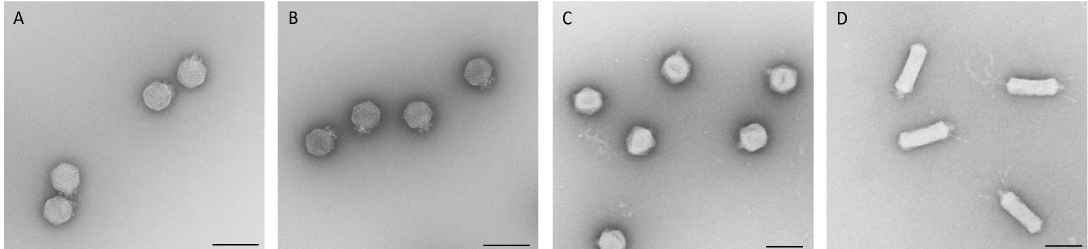
Figure 2. Electron micrographs of isolated phages HASG4 ( A ), HdK1 ( B ), MM01 ( C ), PTXU06 ( D ), and G29-2 ( E ) of the siphoviruses family. Negative staining (2% ( w / v ) uranyl acetate, pH 5.0). Bars represent 100 nm.